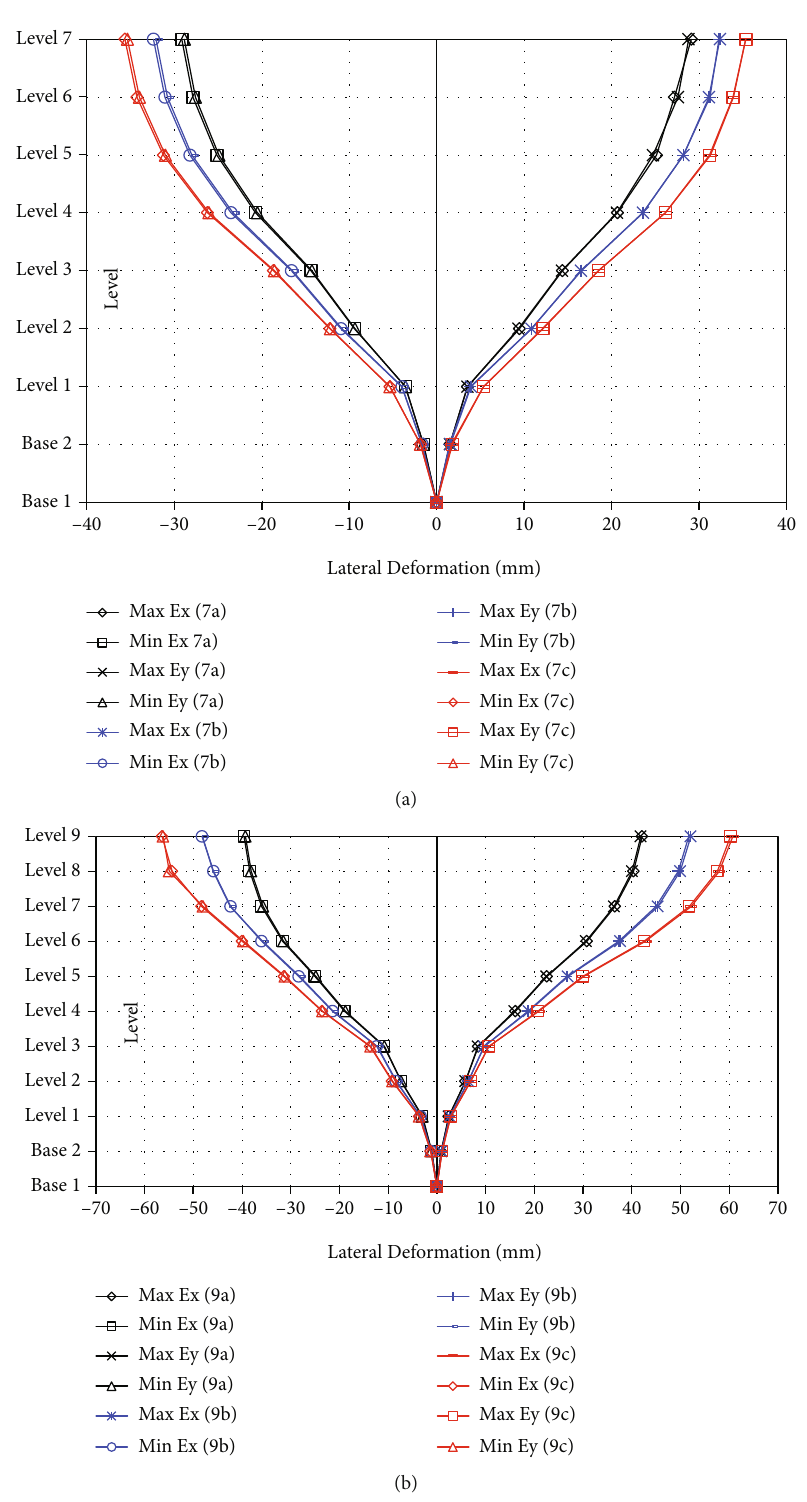
and E Earthquake for Meru levels (a) 7 and (b) x y